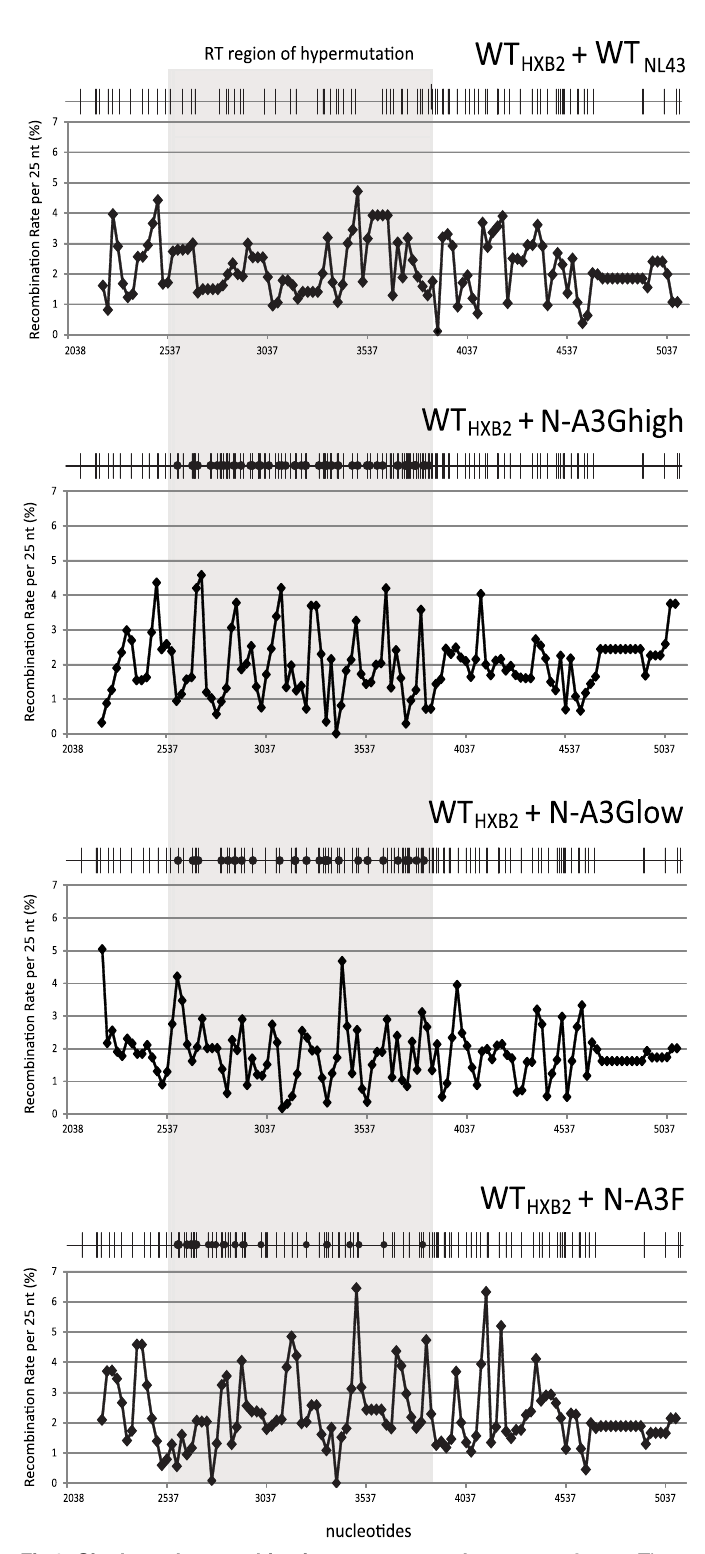
PLOS Pathogens | DOI:10.1371/journal.ppat.1005646 May 17,